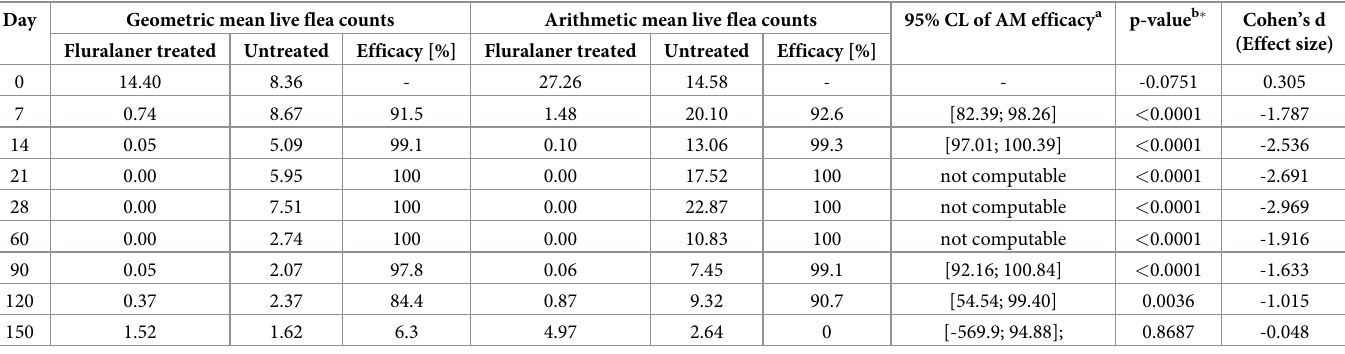
Table 4. Live Tunga penetrans counts (secondary efficacy and p values) on fluralaner treated and untreated dogs at various time points following treatment. Day Geometric mean live flea counts